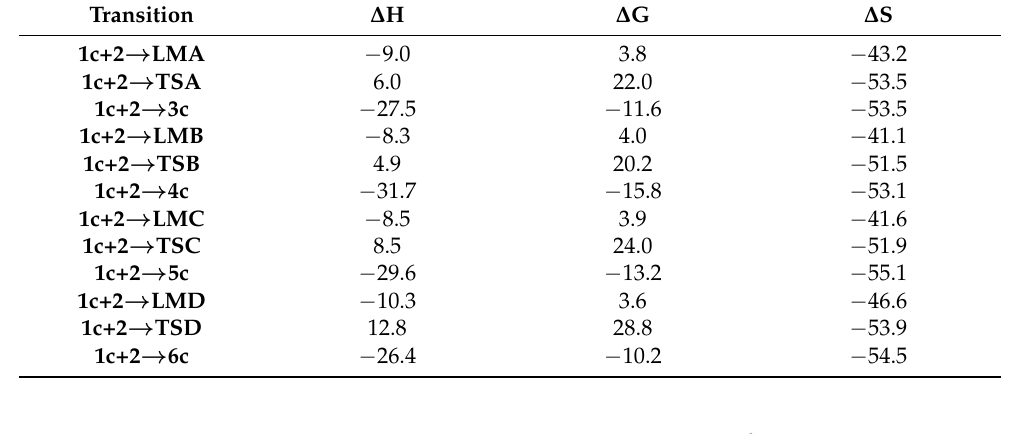
Table 3. Energetical parameters for reaction 1c+2 in light of the wb97xd/6-311+G(d) (PCM) calcula- tions.